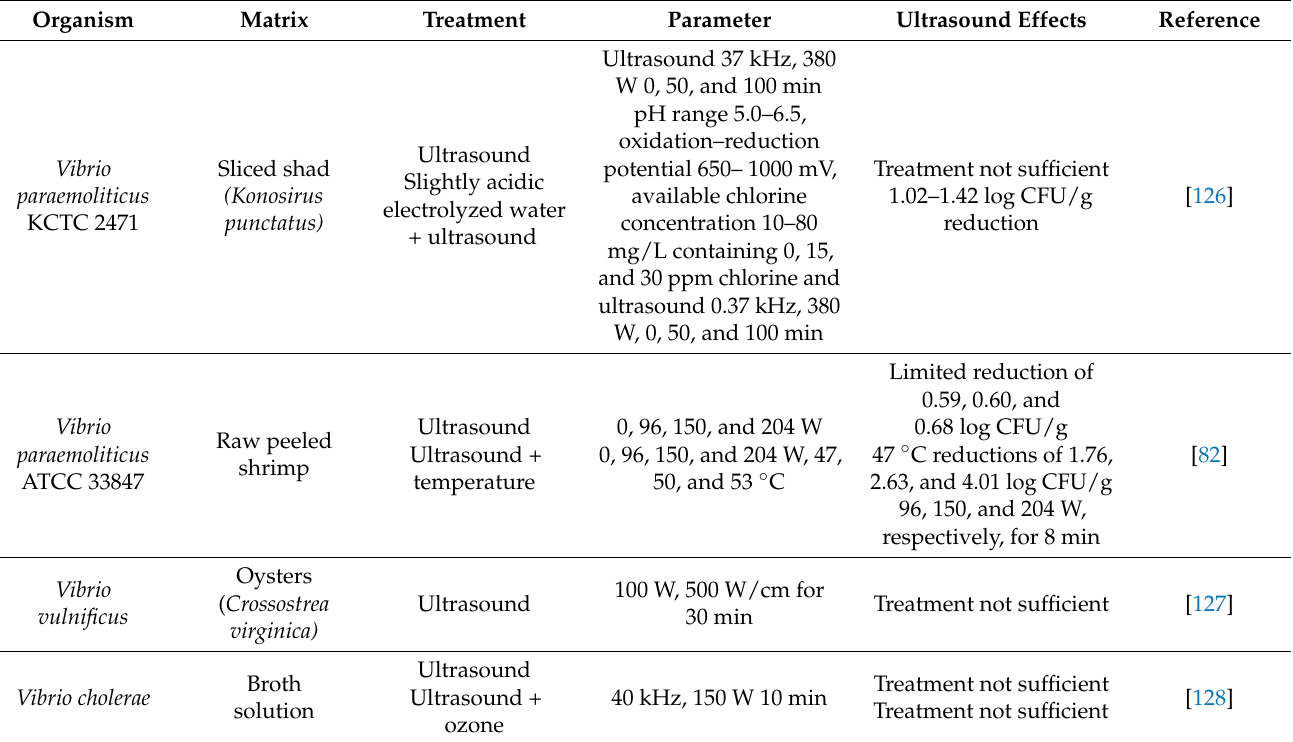
Table 7. Ultrasound effects as single or combined non-thermal technology: Vibrio